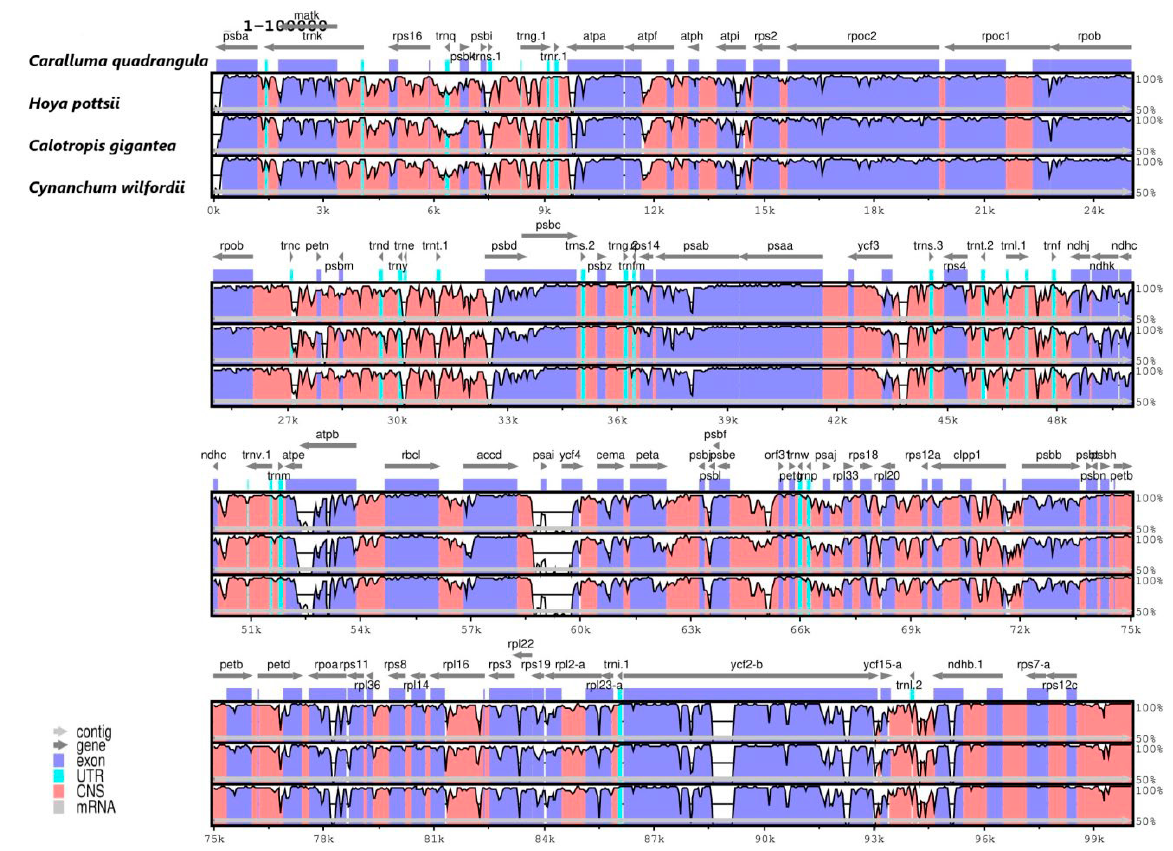
Fig: 6: Comparative analysis of cp genomes for C. quadrangula , H.pottsii, C. wilfordii, and C. gigantea, computed with VISTA program, in which the sequence of C. quadrangula was used as a reference. The black-grayish arrows on top of the alignment show the orientations of genes and Inverted repeat positions. Purple, pink, and gray color bars, as well as white peaks, denote exons. Similarly, untranslated Region (UTRs), mRNA, conserved non-coding Sequence (CNSs), and the genome differences are all represented in (Fig. 6); a 70% identity value was used for the plot, while a 50-100% percentage scale was used to measure the